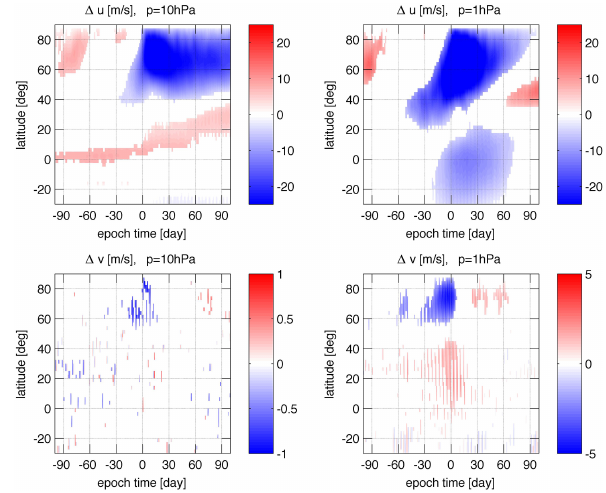
Figure 5. Composites of the anomalies (cid:49)u at 10hPa (upper left) and at 1hPa (upper right). Values are only shown if they exceed the 2 σ level. Eastward wind anomaly of − 59ms − 1 is reached at 1hPa. Composites of the anomalies (cid:49)v at 10 and at 1hPa are shown in the lower